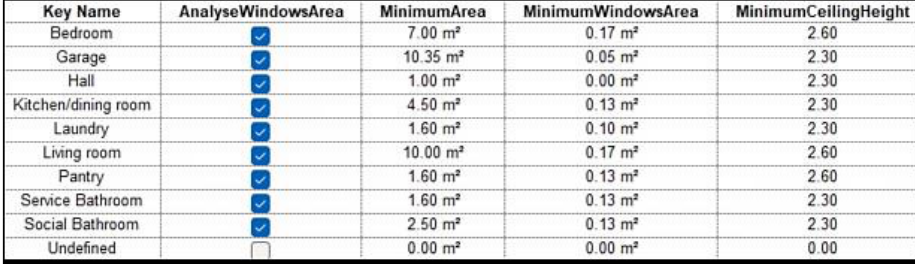
Figure 8. Building code requirements per compartment for Vila Velha and Florianópolis.